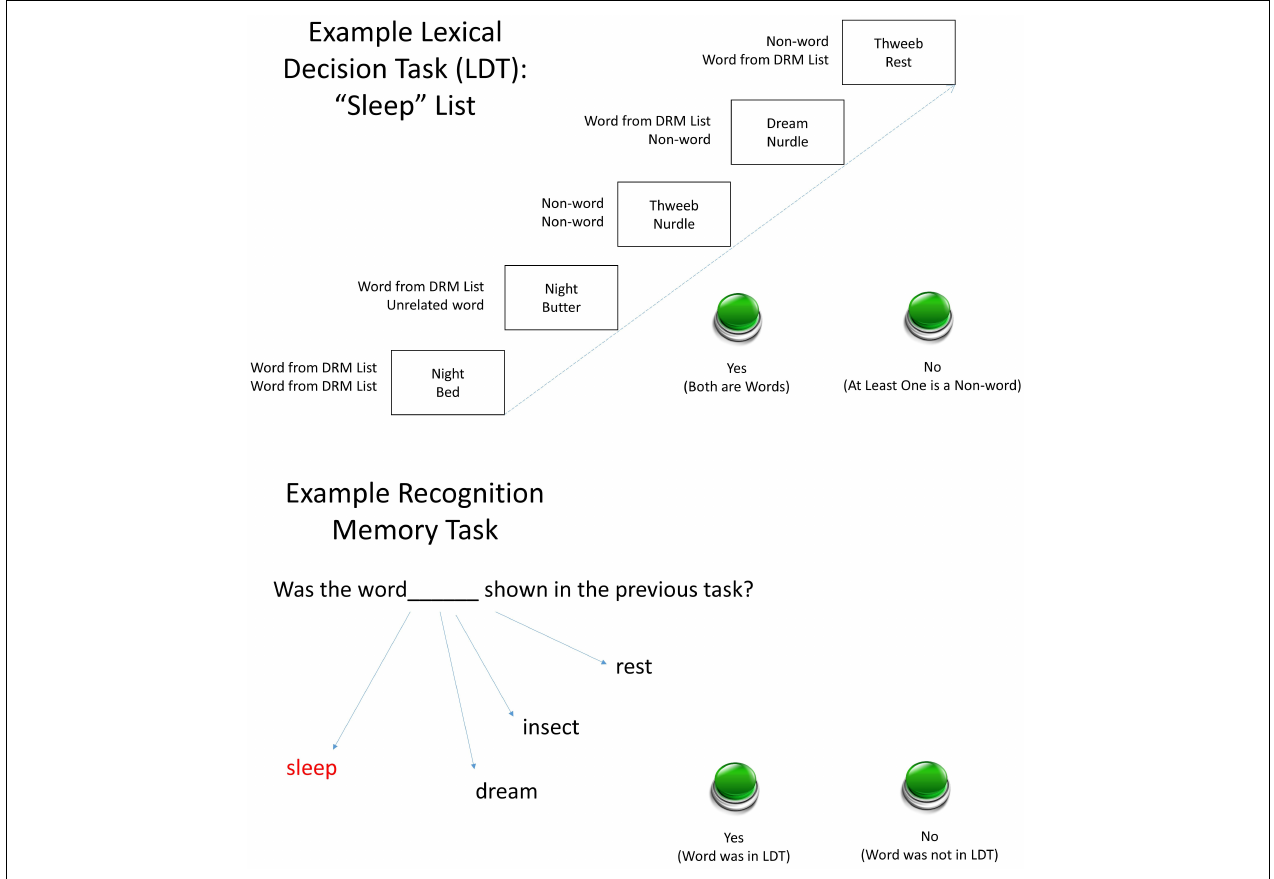
FIGURE 1 | Examples of the two-item trial types during the LDT phase (Top) and the recognition memory test (Lower) . Error bars show standard errors. Participants completed the LDT encoding phase involving two-item letter strings composed of words from six DRM lists and/or non-words, followed by a recognition testing phase. Accuracy and reaction time (RT) were